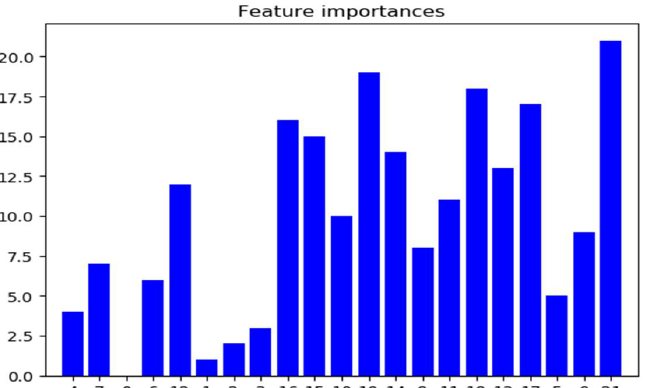
Figure 9. Importance of data features.